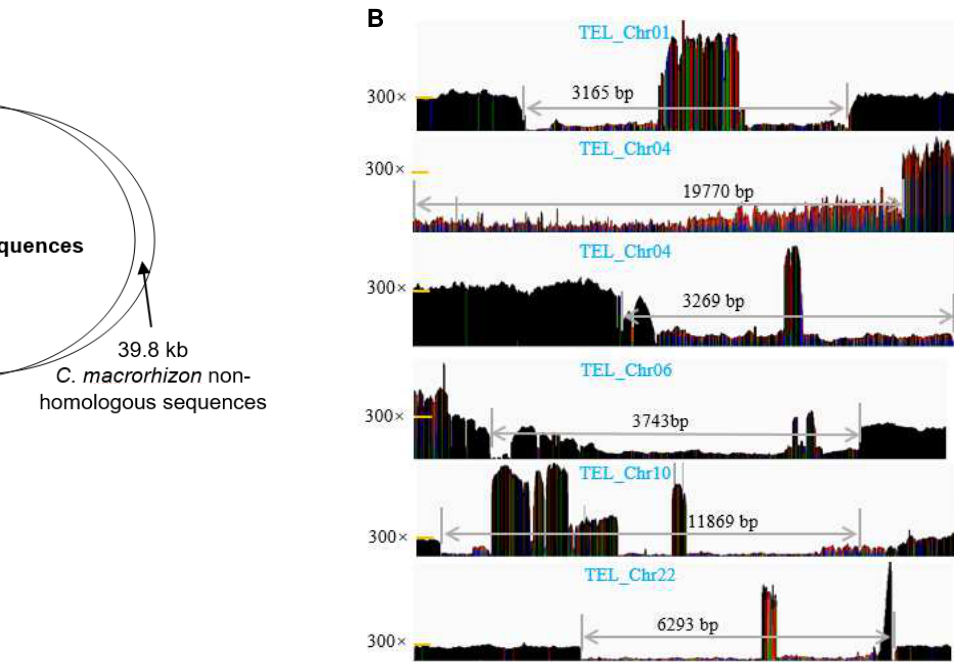
Figure 2. The maintenance and turnover of homologous sequences in the C. lancifolium and C. macrorhizon mitogenomes. ( A ) The relative composition of homologous and non-homologous se- quences in the two mitogenomes. ( B ) Validation of C. lancifolium non-homologous sequences by using C. macrorhizon short reads. The gray arrows highlight the six largest indels caused by the maintenance of C. lancifolium -specific